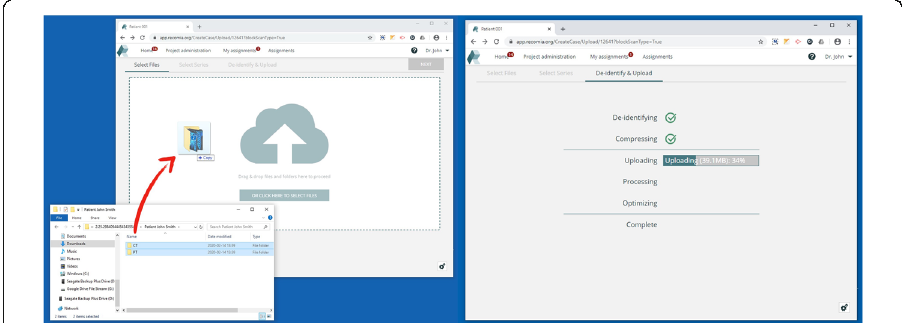
Fig. 2 Dicom files using drag-and-drop (left). Before leaving your device, the image files are automatically de-identified